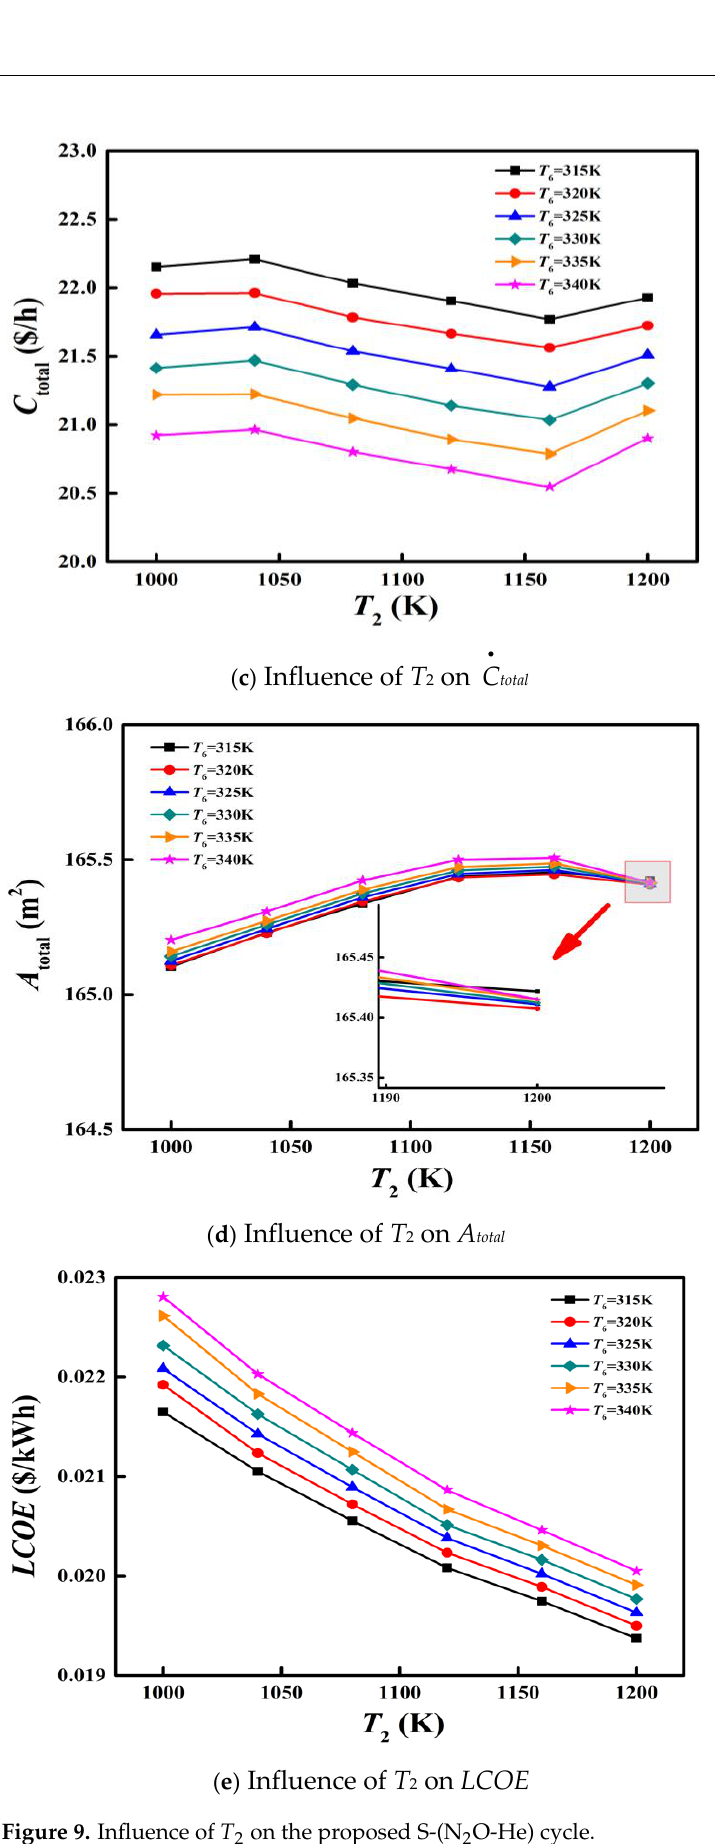
2 on the proposed S-(N 2 O-He)